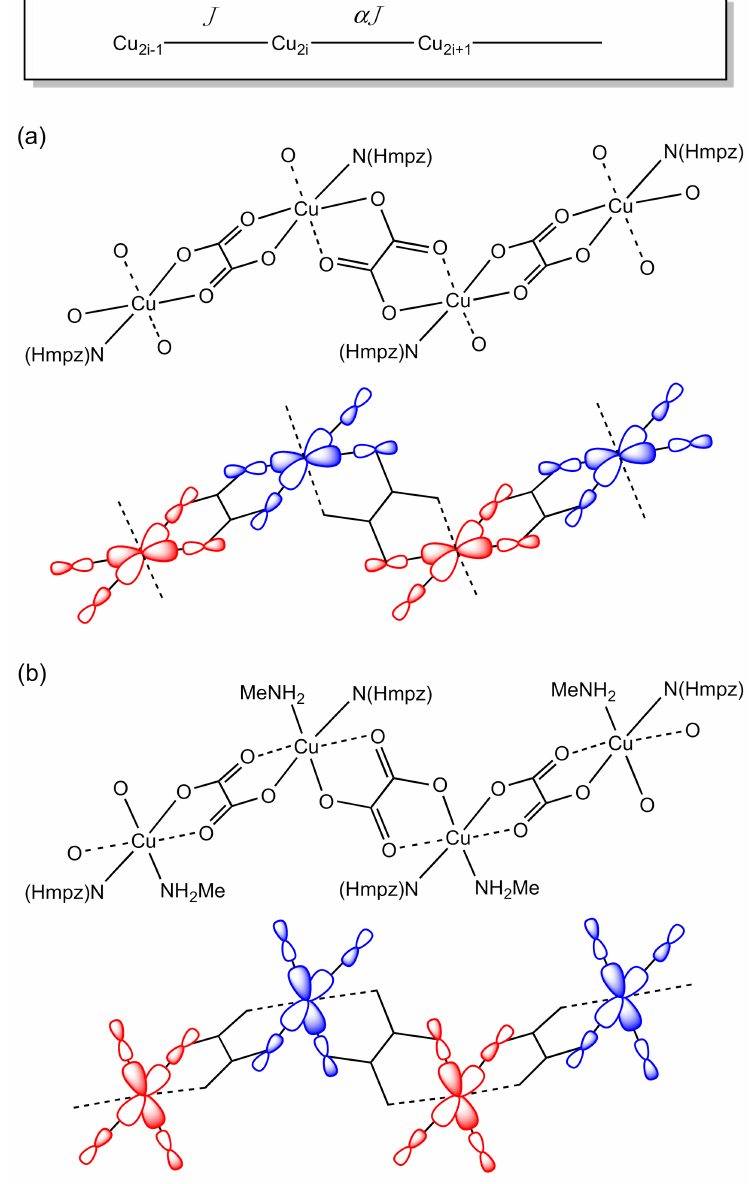
Scheme 1. Illustration of the magnetic coupling model for an alternating copper(II) chain showing the relative orientation of the magnetic orbitals centered on each copper(II) ion for 1 ( a ), relative to 2 and 3 ( b ). The solid and dashed lines represent short and long metal-ligand bonds,